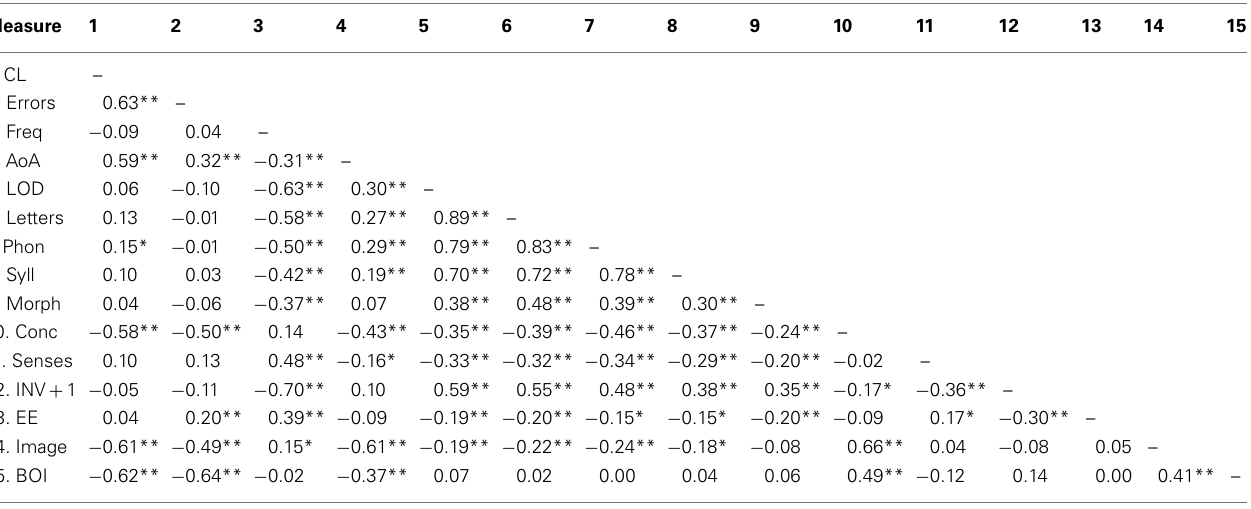
Table 2 | Zero-order correlations between the criterion variables and the predictor variables for the concrete SCT. Measure